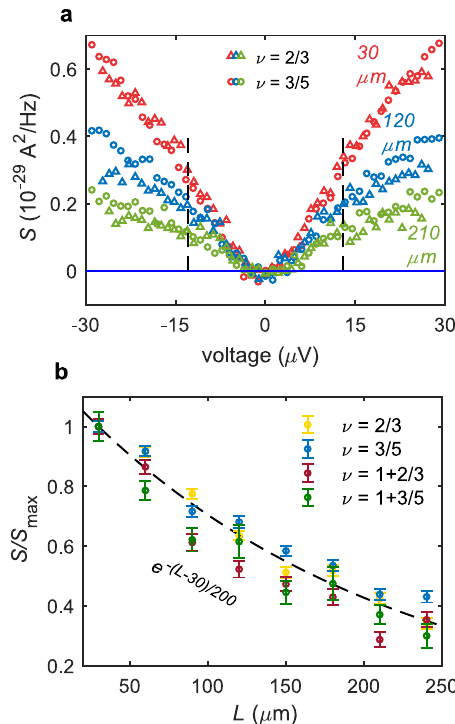
Fig. 2 Length pro fi le of the upstream noise in different states. a Upstream noise as a function of the applied bias to the Source for ν ¼ 2 (triangles) 3 and ν ¼ 3 (circles), for a few propagation lengths; 30 μ m (red), 120 μ m 5 (blue), 210 μ m (green). The dashed lines mark the voltage for which the length dependence pro fi le was determined. b Length dependence of the upstream noise. The noise is normalized (with respect to shortest length) separately for each fi lling factor. Error bars represent the statistical error. The noise pro fi le of all fi llings matches nicely with exponential decay with a typical decay length of 200 μ m (dashed line). This indicates the dominant role of dissipation rather than thermal